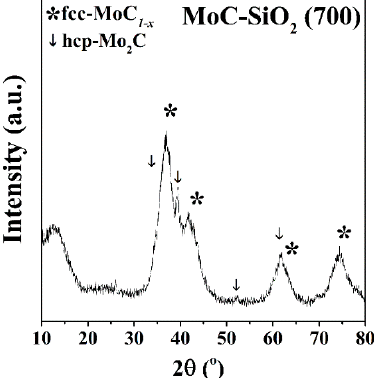
Figure 3. XRD pattern of the calcined MoC–SiO 2 (700) catalyst.